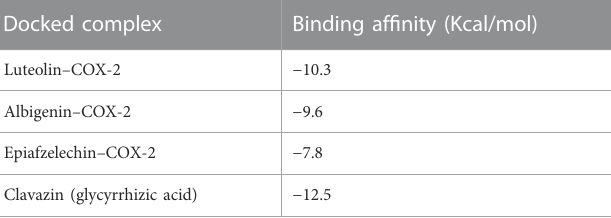
TABLE 4 Binding af fi nities of phytocompounds and clavazin against COX-2. Docked